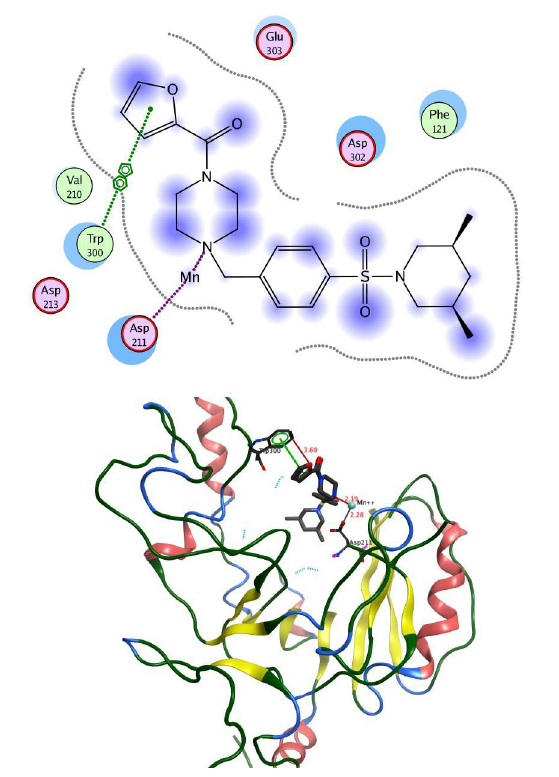
FIGURE 2 - The 2D and 3D interaction analysis of 4-{4-[(3,5-dimethyl-1-piperidinyl)sulfonyl]benzyl}-1-